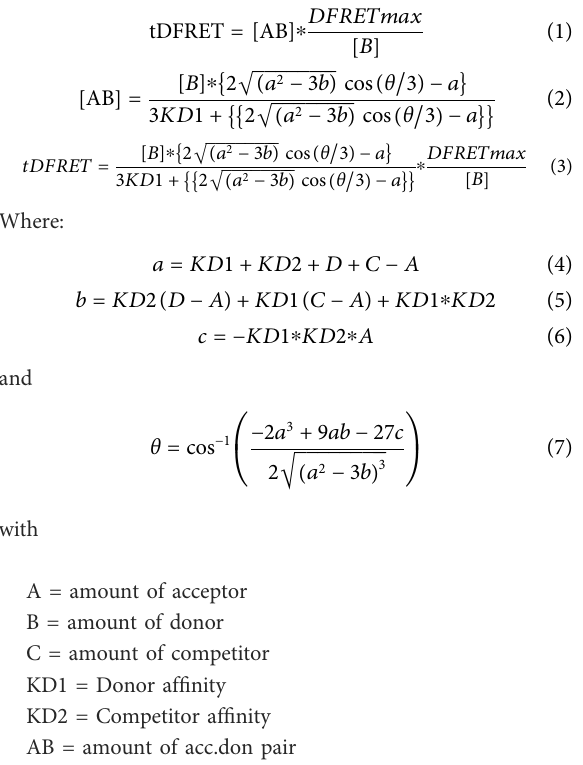
A fi tting algorithm was used to fi nd the parameters: KD1 app , KD2 app and DFRETmax, by minimizing the mean squared error (MSE) between the observed DFRET (oDFRET) and the